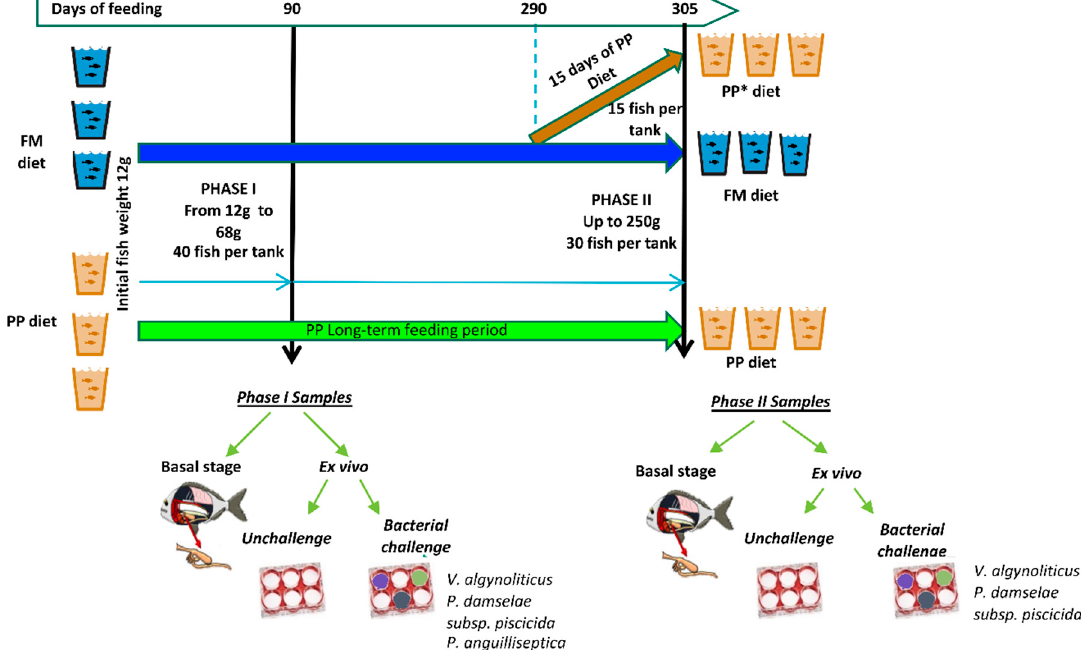
Figure 7. Summary of the experimental design. The impact of dietary fish protein substitution by plant protein in fish immune response to the ex vivo bacterial challenge was evaluated at two on-growing phases: 12–68 g (90 days) and up to 250 g (305 days). Additionally, a group was included at 305 days to estimate the effect of short-term fish meal substitution (15 days; PP*).